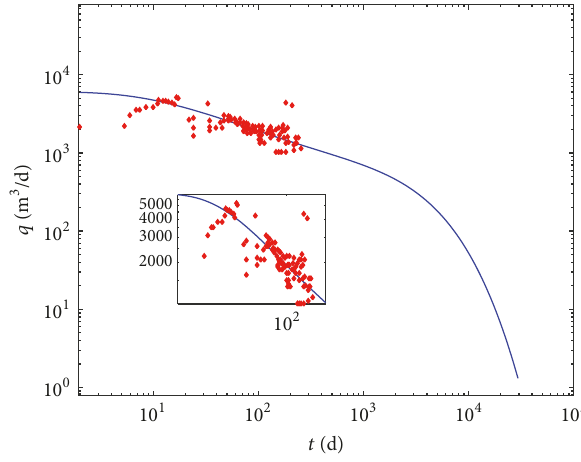
Figure 16: History matching of typical